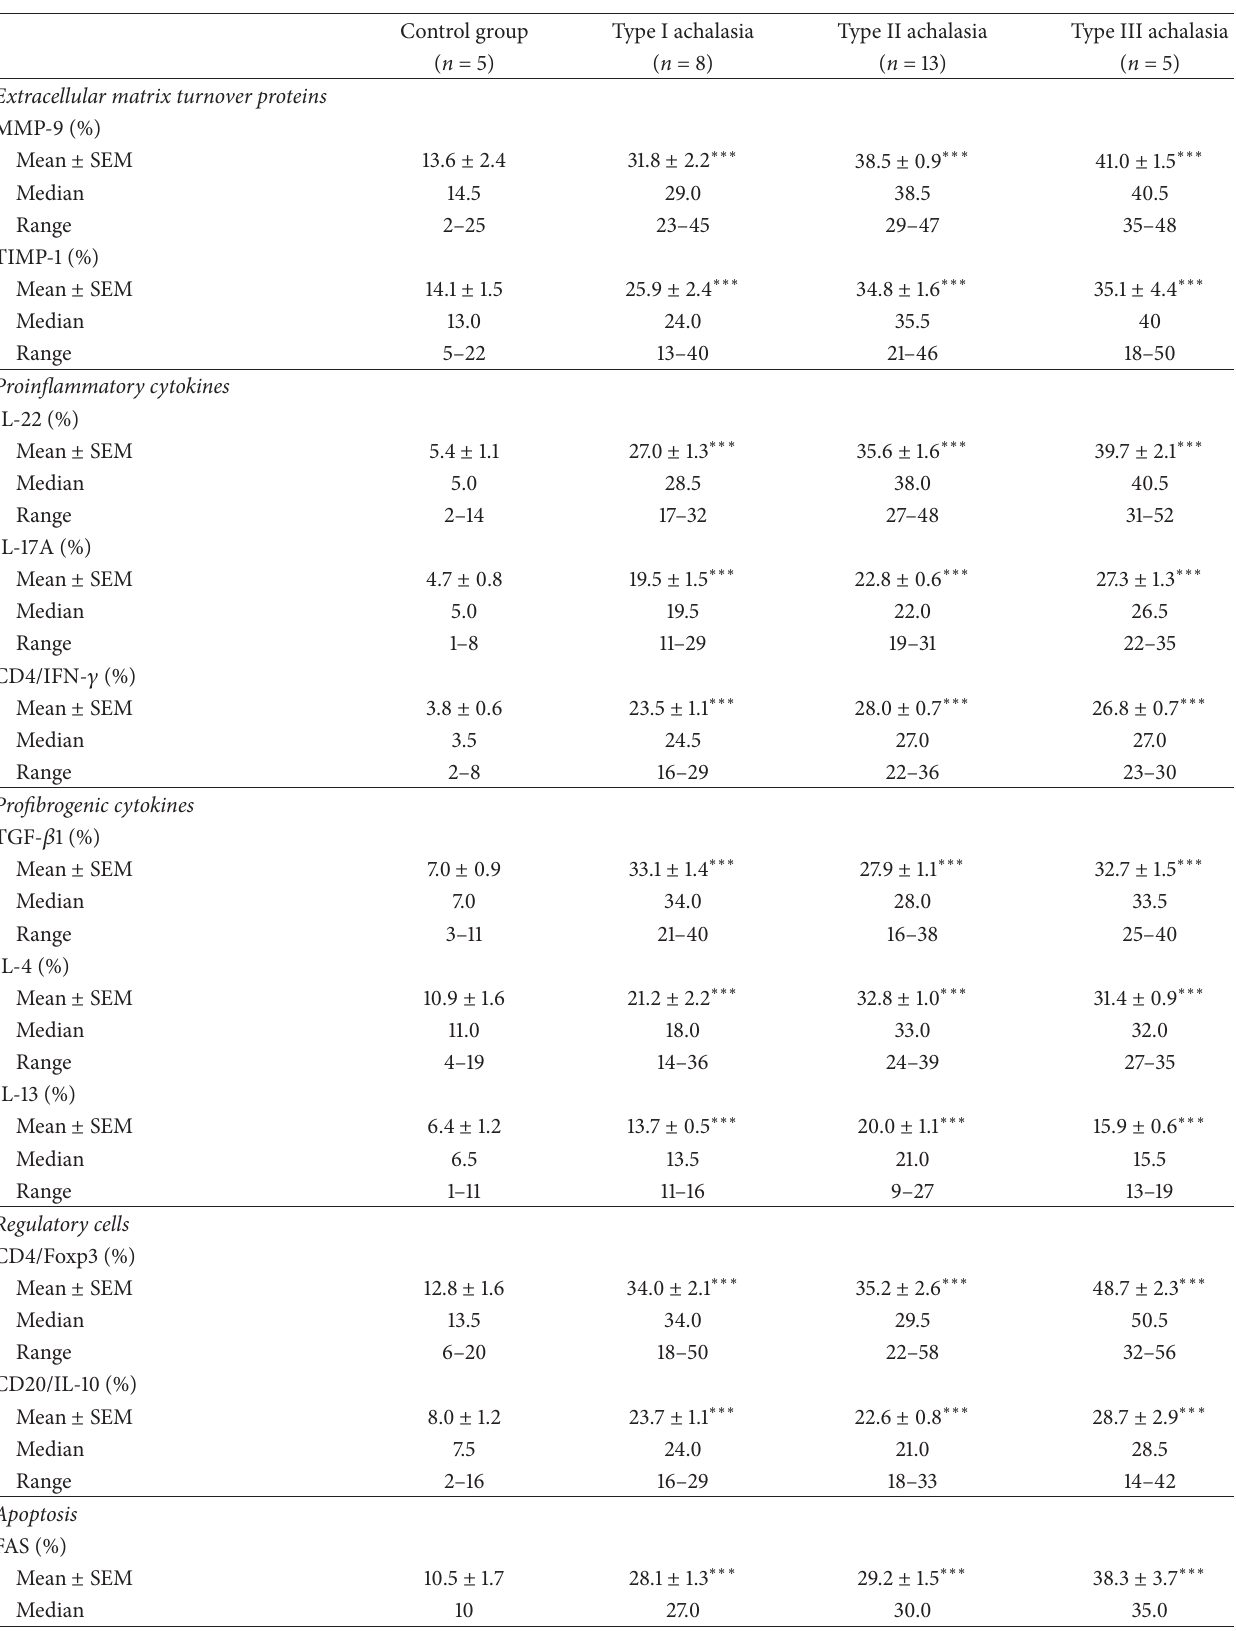
Table 2: Percentage of immunoreactive cells in achalasia